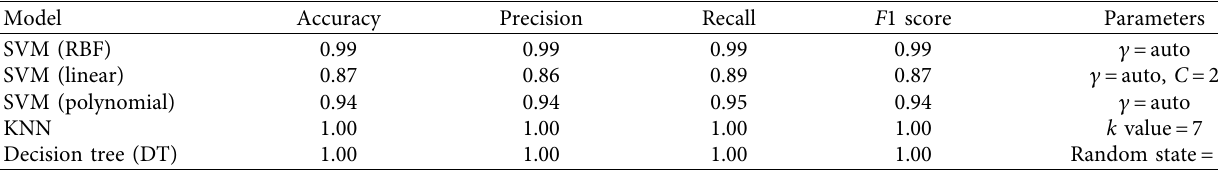
Table 13: Extroversion classifcation report.